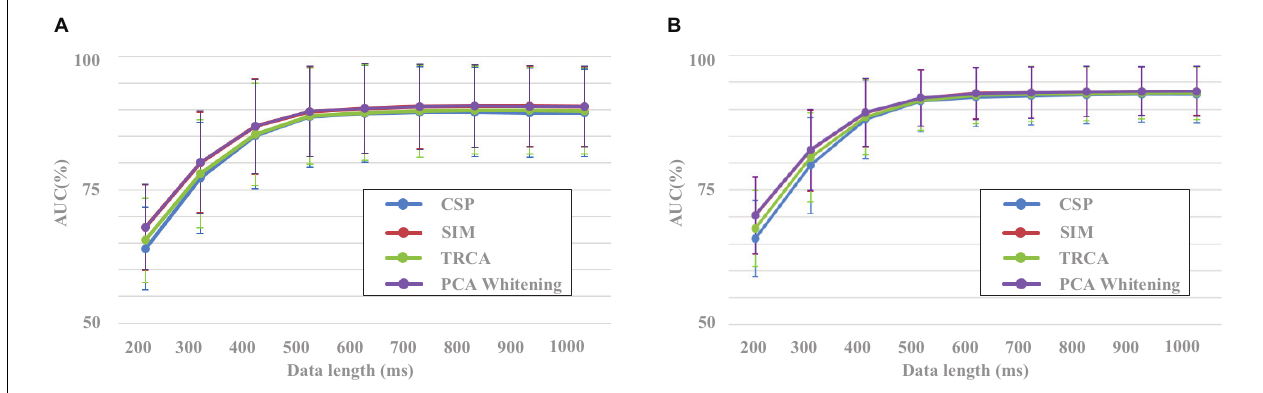
FIGURE 5 | Performance of different data lengths for spatial filtering methods (A) Block 1 for training and block 2 for testing. (B) Result of 10-fold cross-validation using both blocks 1 and 2.